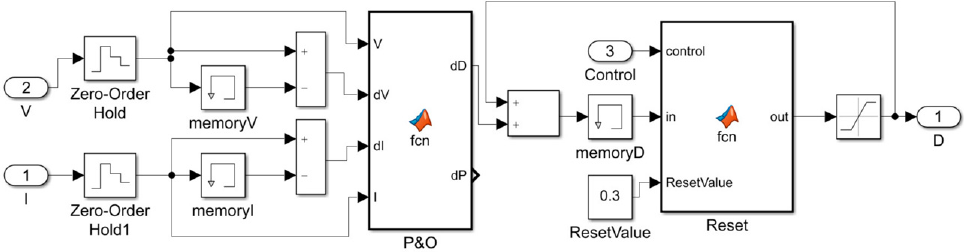
Figure 2. MPPT model based on modified hill-climbing